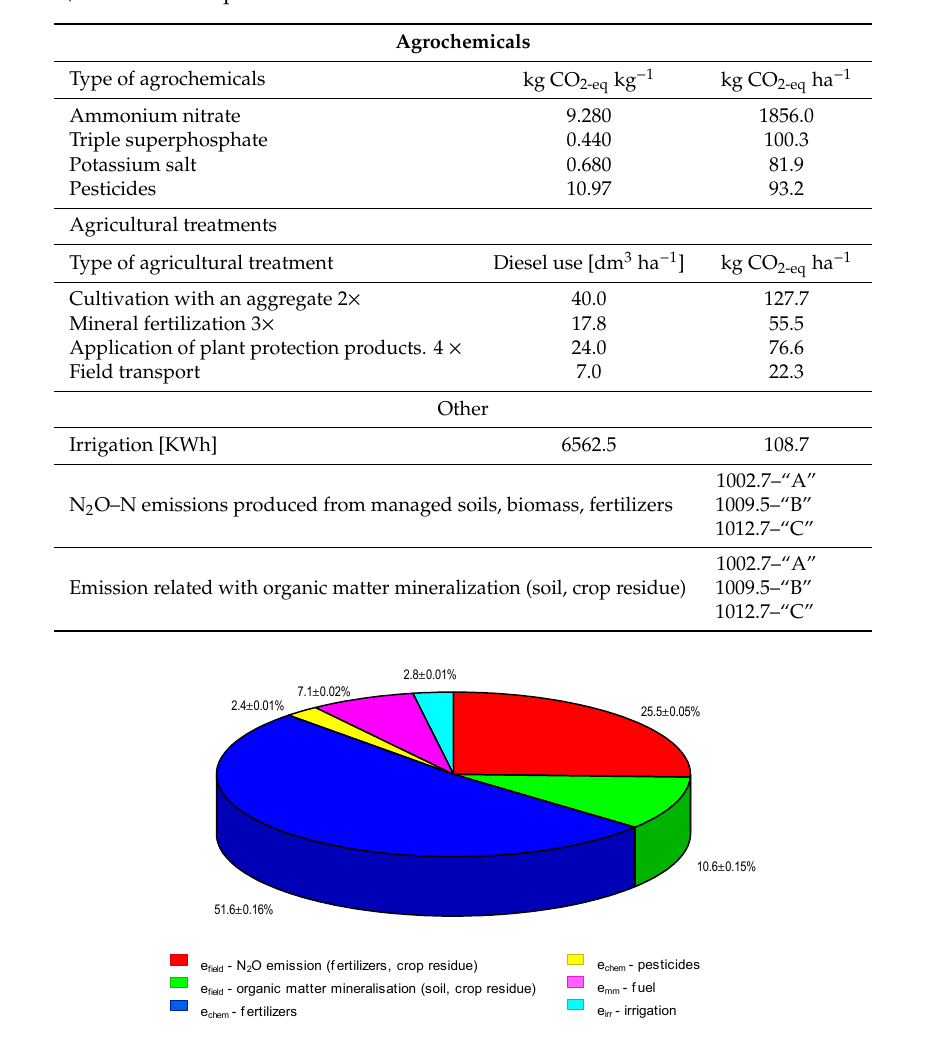
Figure 6. Structure of GHG emissions (%), average for training systems (A, B, C), ± standard deviation.